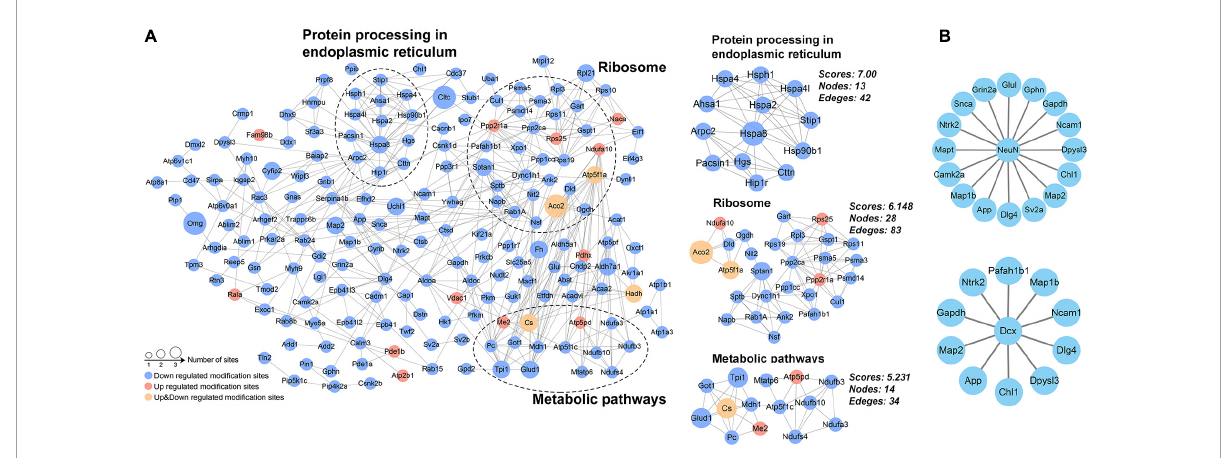
FIGURE6 Protein–protein interaction network analysis. (A) Network for the differentially acetylated proteins and the three most highly connected subnetworks (metabolic pathways, ribosome, and protein processing in endoplasmic reticulum). (B) The differentially acetylated proteins were connected with the markers of adult neurogenesis (NeuN and